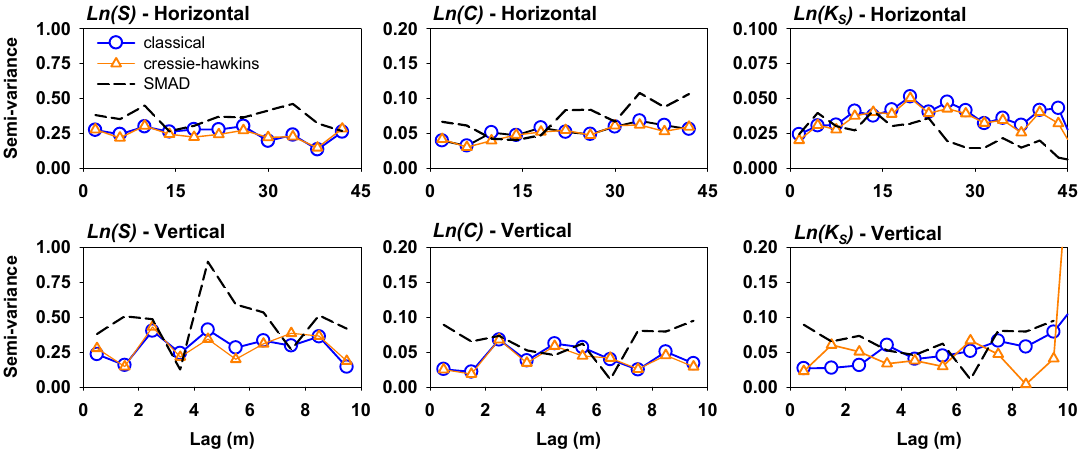
Figure 5. Horizontal and vertical experimental semi-variograms for Ln(S) , Ln(C) , and Ln(K S ) using classical, Cressie–Hawkins, and SMAD estimators.